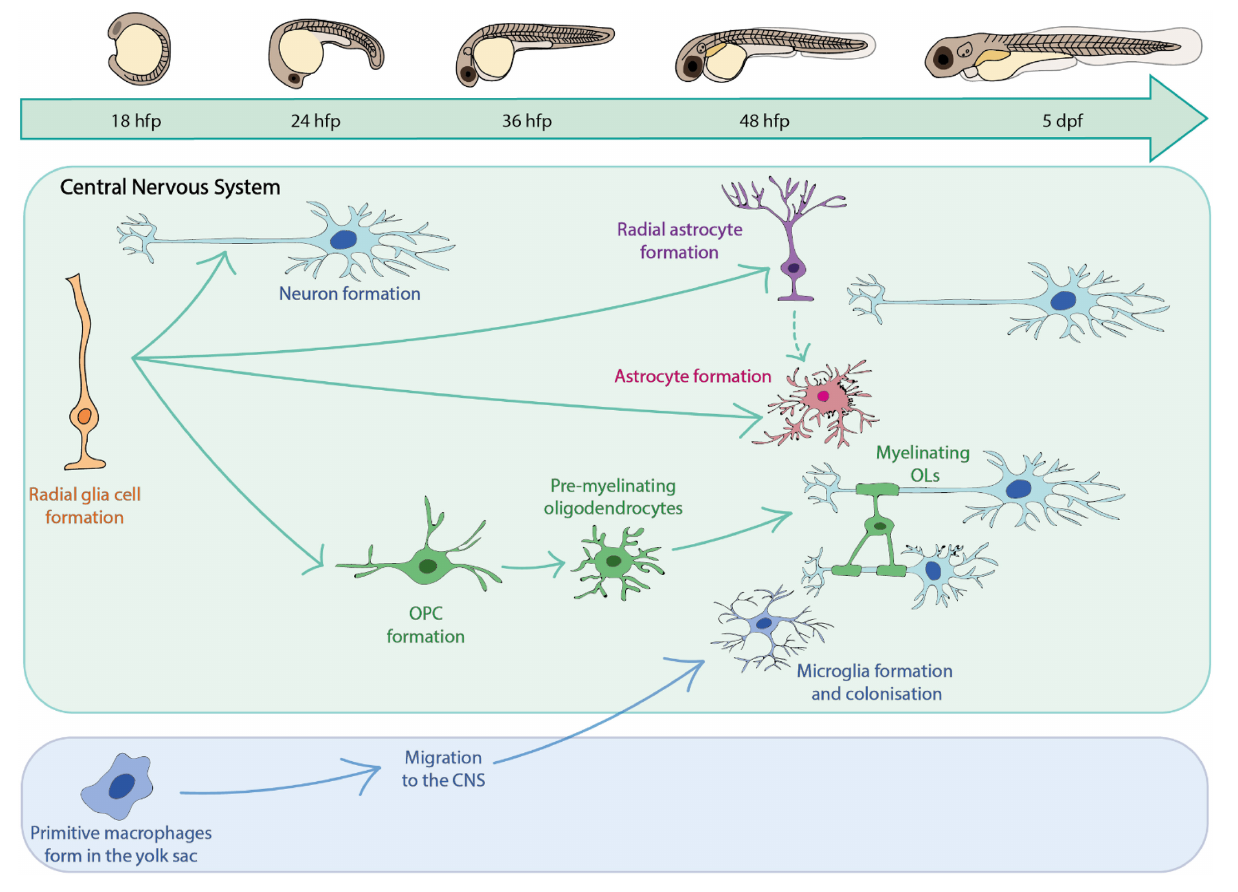
FIGURE 1 | A summary of key glial cells of the zebrafish central nervous system and their timeline of